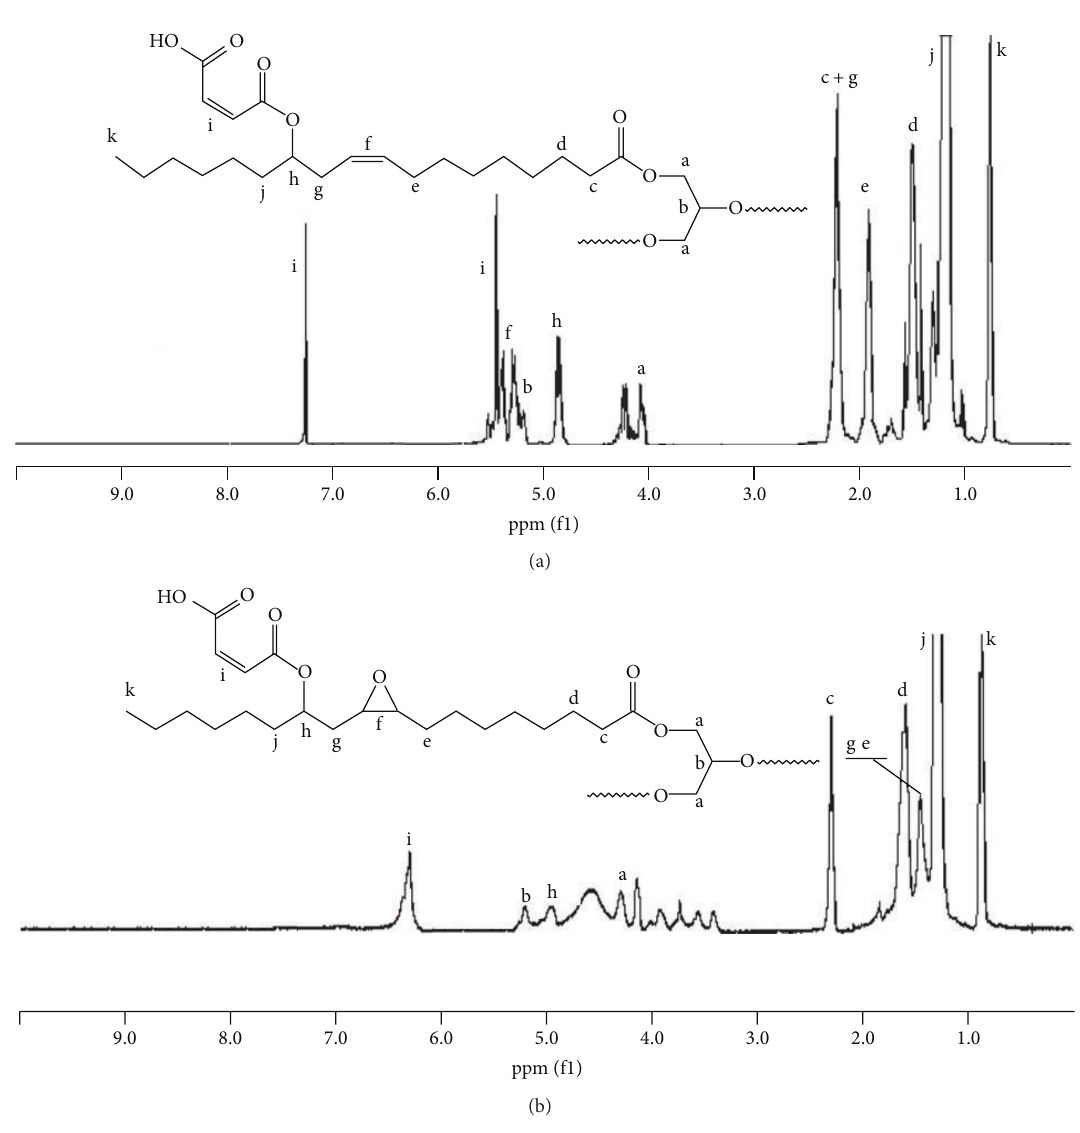
Figure 3: 1 H NMR spectrum of (a) maleinated castor oil and (b) epoxidized maleinated castor